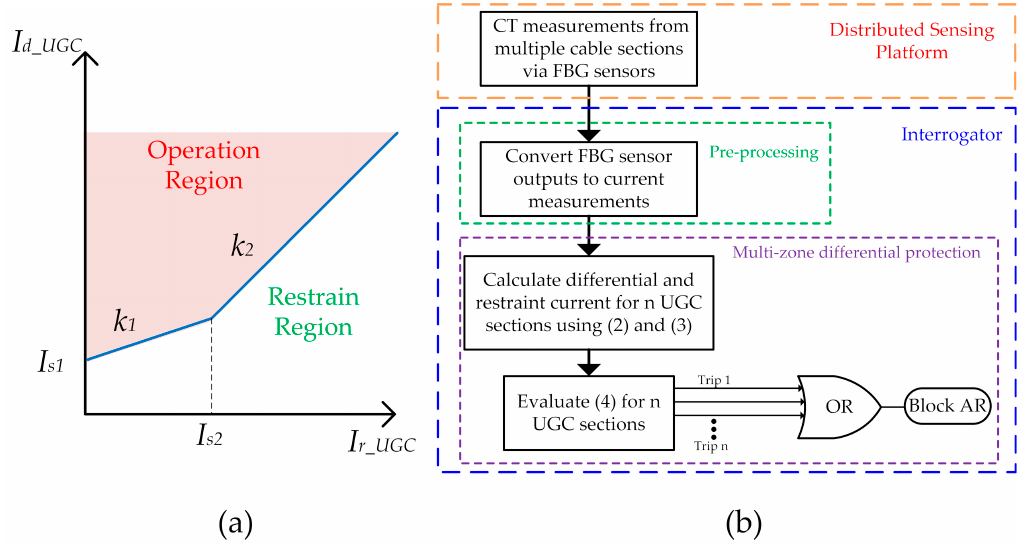
Figure 2. ( a ) Two-slope differential current characteristic; ( b ) selective AR